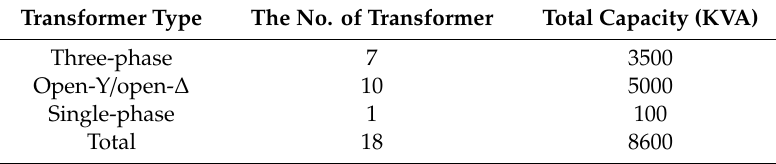
Table 3. The optimal phase connected to distribution transformers.